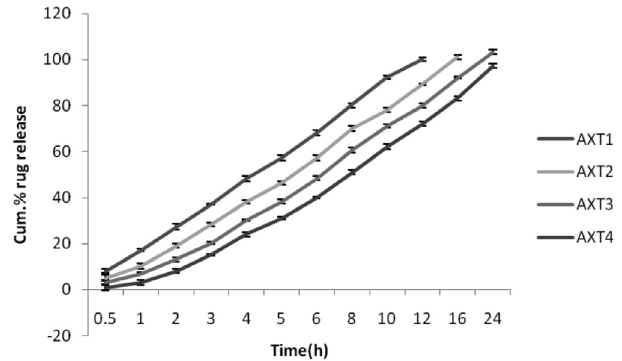
FIGURE 6 - Cumulative percentage drug release of fromulations (AXT 1 to AXT 4) in SCF.